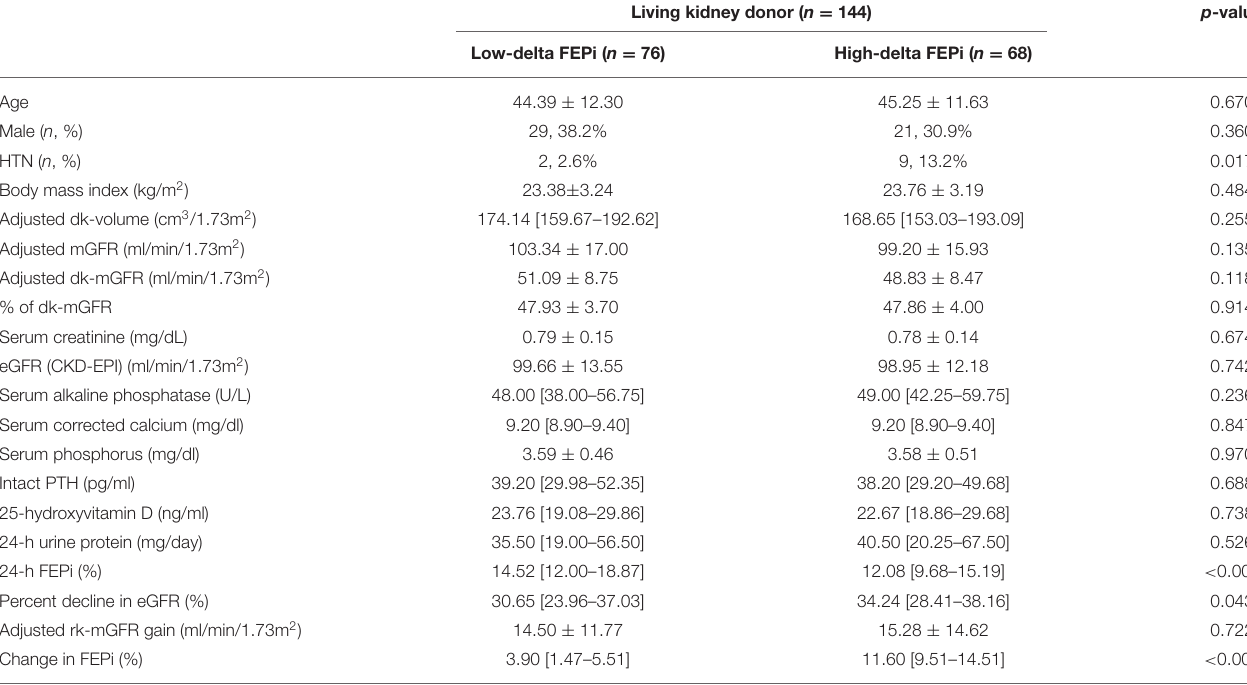
TABLE 3 | Comparison of the clinical characteristics and biochemical parameters according to the difference of FEPi after uni-nephrectomy.